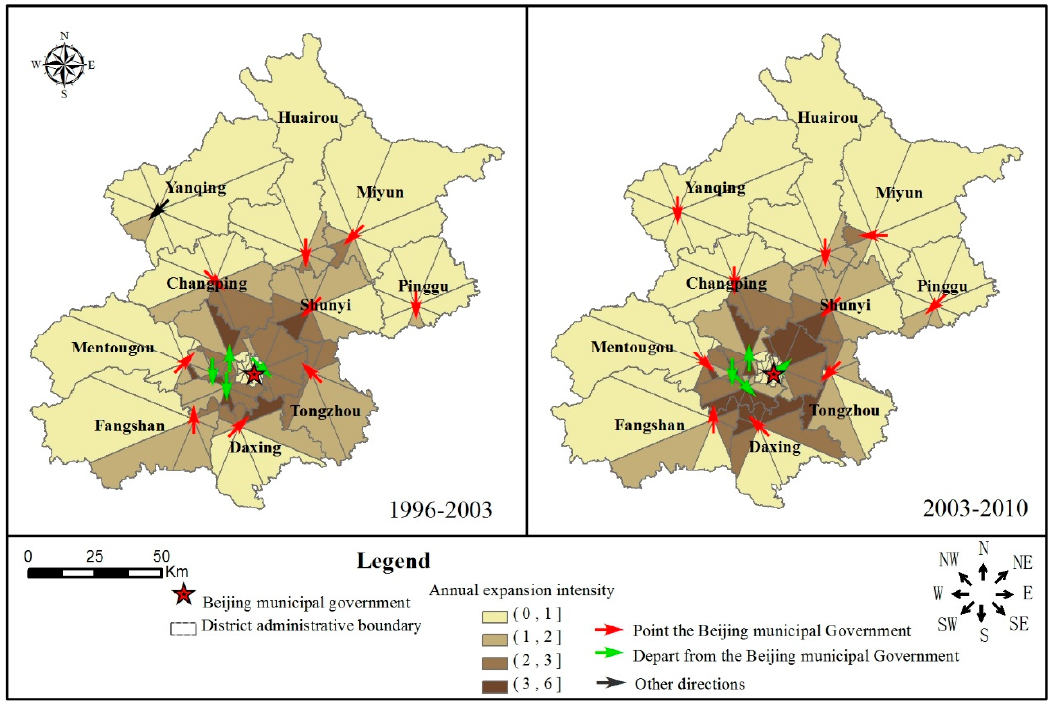
Figure 12. Expansion directions and annual expansion intensity at district level.